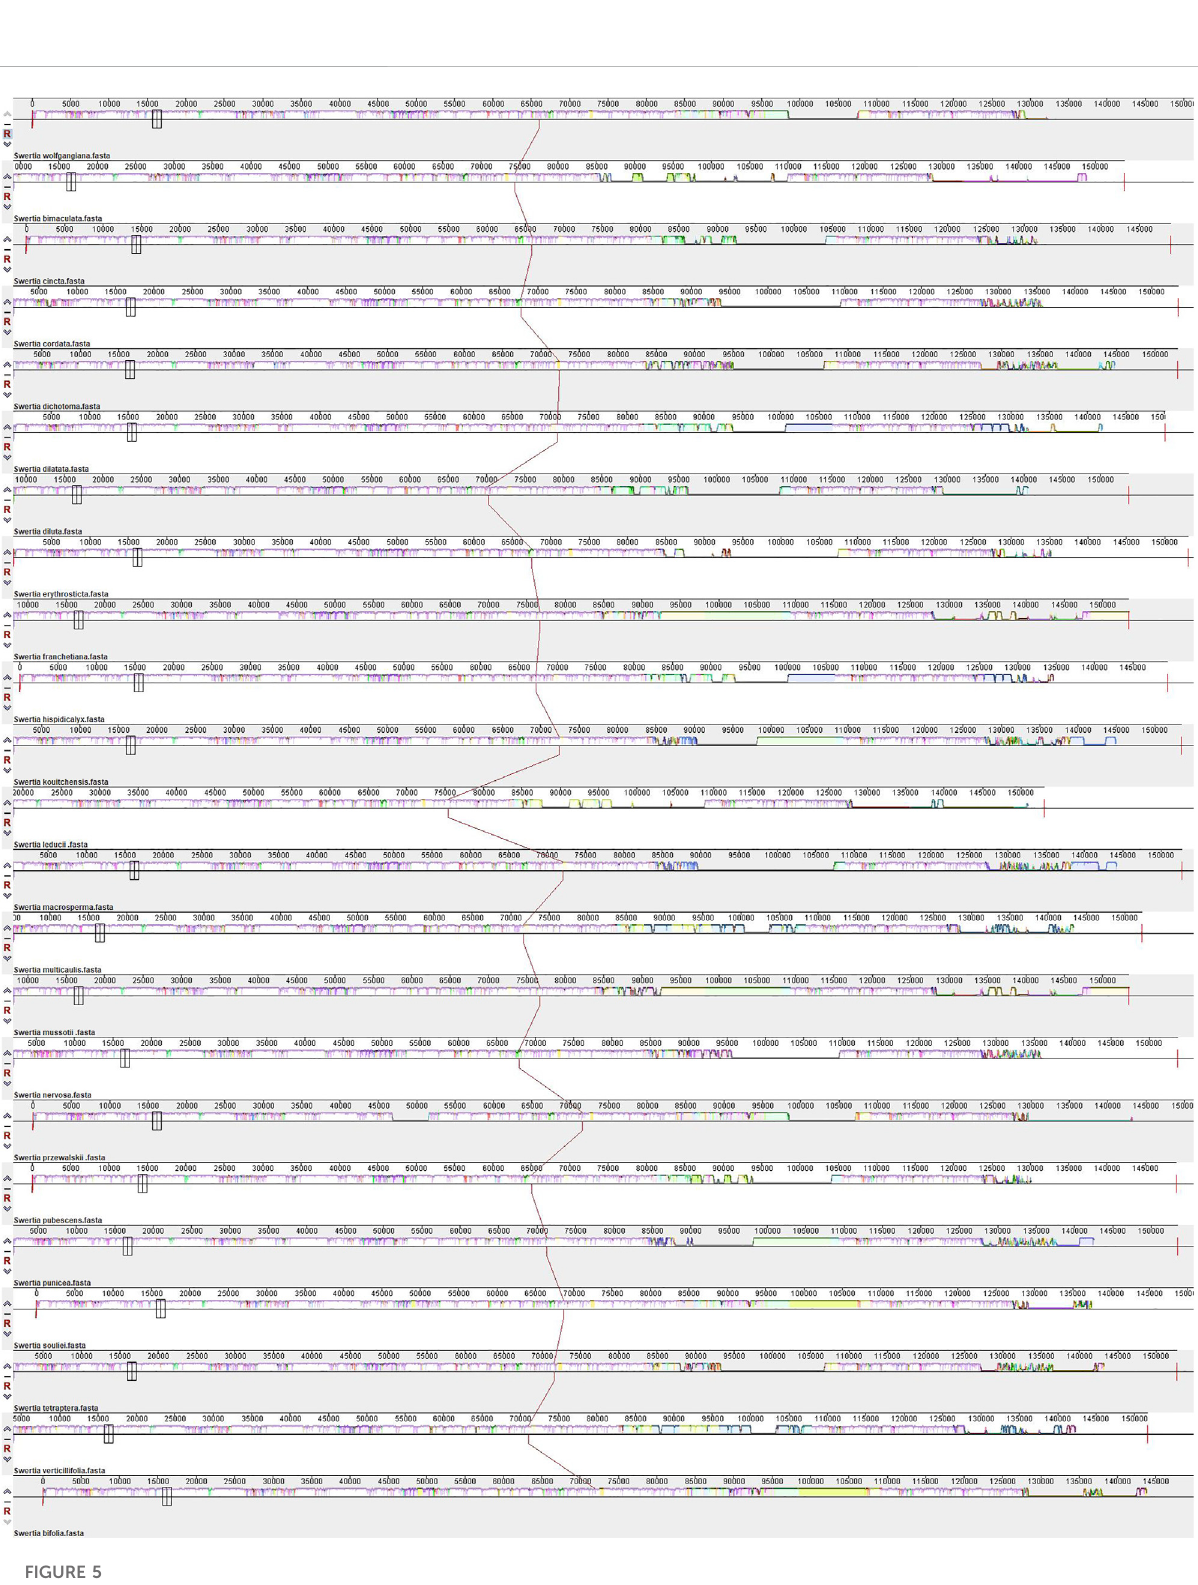
FIGURE 5 MAUVE alignment of 23 Swertia L. species chloroplast genomes. The S . wolfgangiana genome is shown at the top as the reference